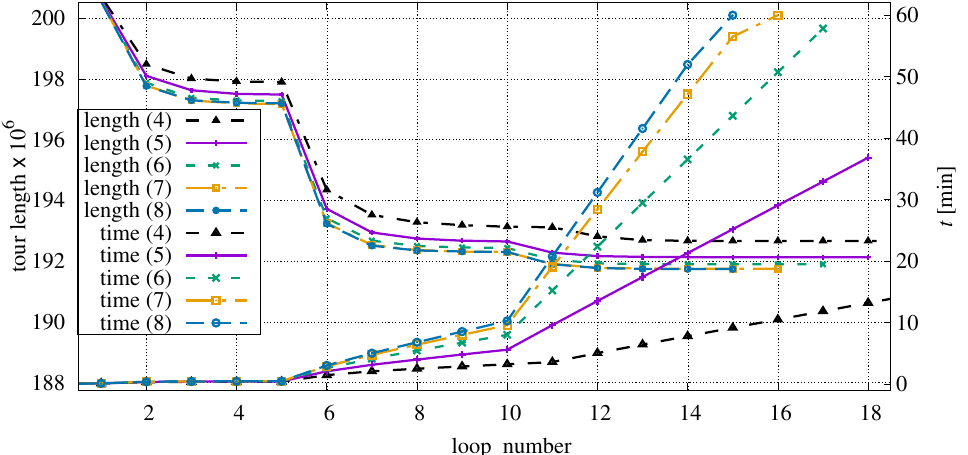
Figure 10. Influence of maximum number maxC ∈ ( 4,5,6,7,8 ) of candidates exemplified on instance C316k.0.